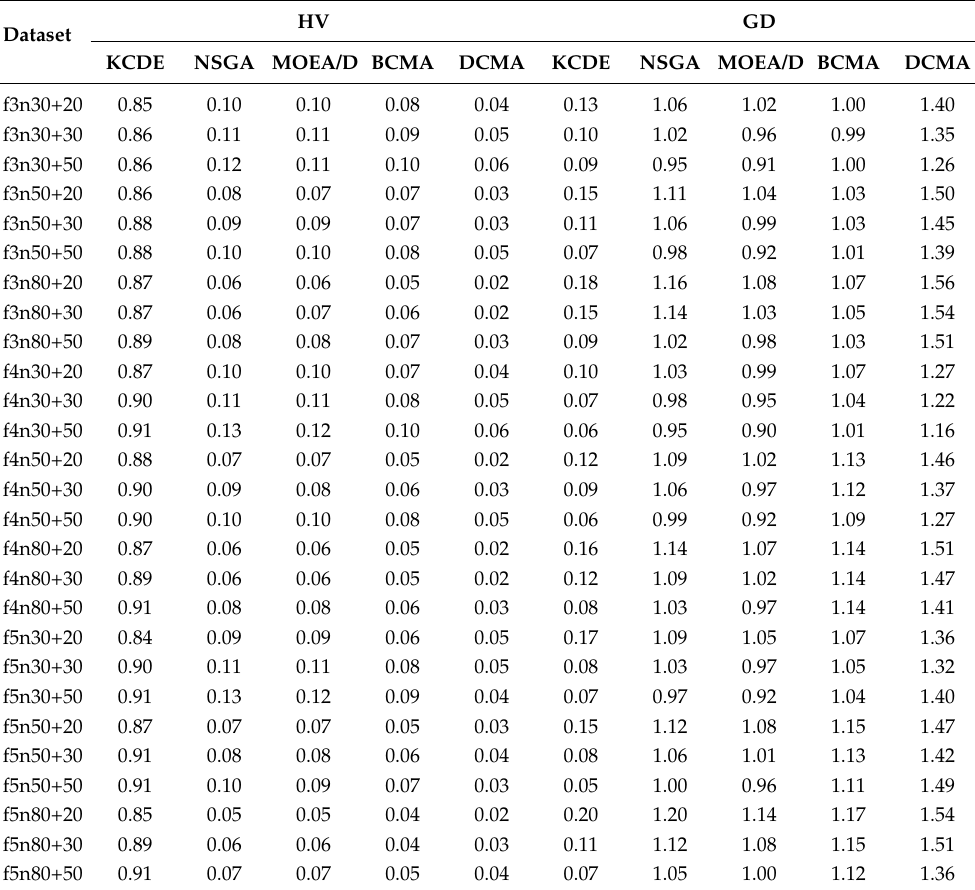
Table 8. HVs and GDs of KCDE and NSGA-II, MOEA/D, BCMA,